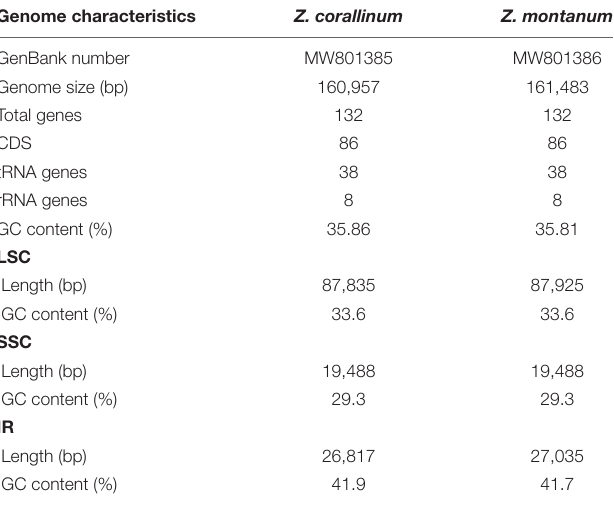
TABLE 3 | The simple sequence repeat (SSR) types of the two chloroplast genomes of Zingiber species. SSR